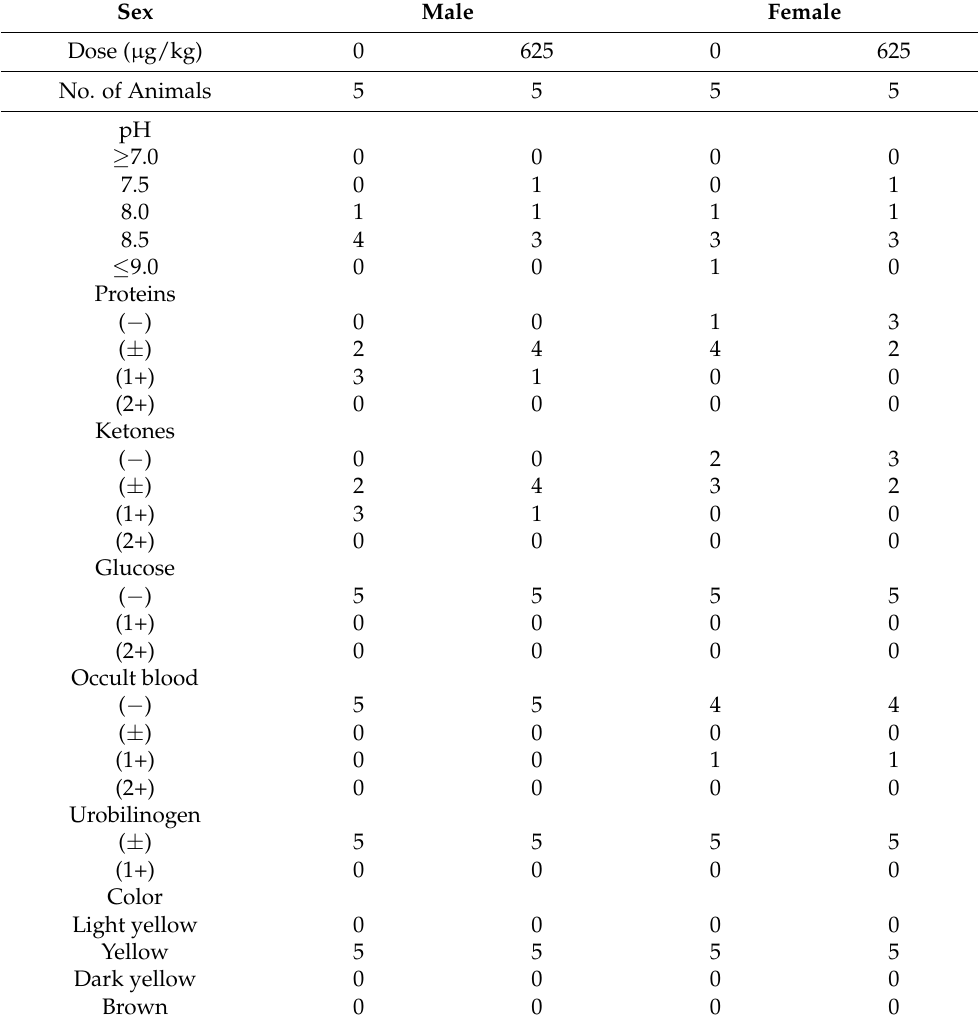
Table 4. Results of urinalysis (day 11 after